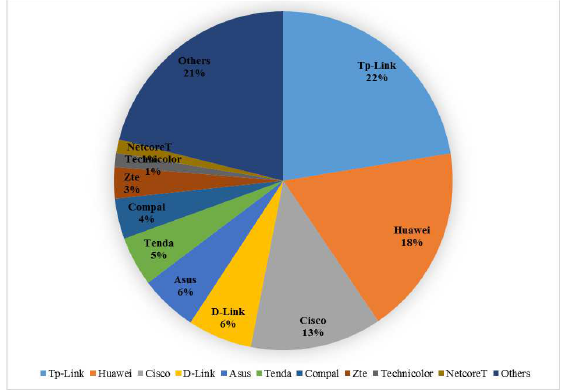
Figure 8. Top equipment manufacturers on sale in Romania Table 6. Provider wireless networks percentage